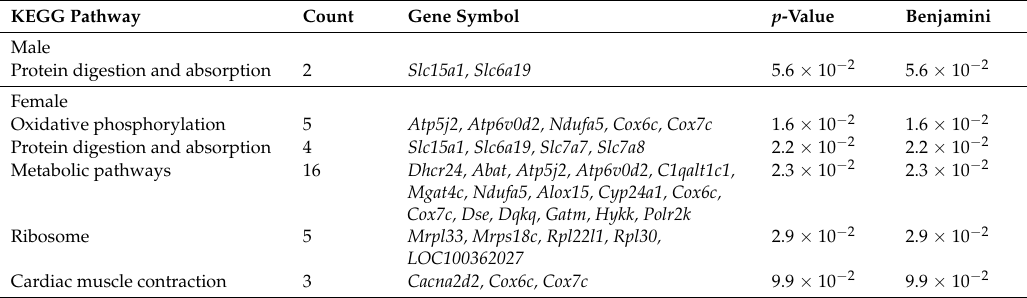
Table 3. Significantly regulated Kyoto Encyclopedia of Genes and Genomes (KEGG) pathways in the one-week-old offspring kidneys exposed to maternal high-fat (HF) consumption. KEGG Pathway Count Gene Symbol p -Value